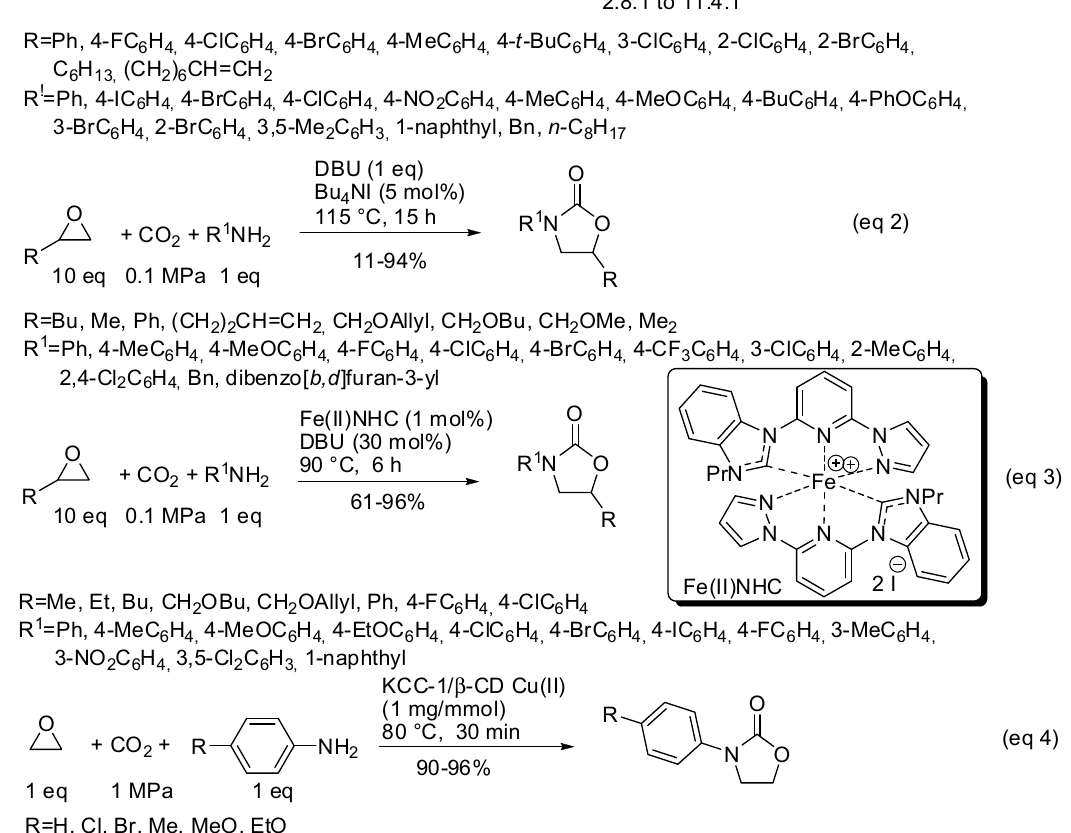
Scheme 21. Three-component reactions among CO 2 , amines and epoxides.